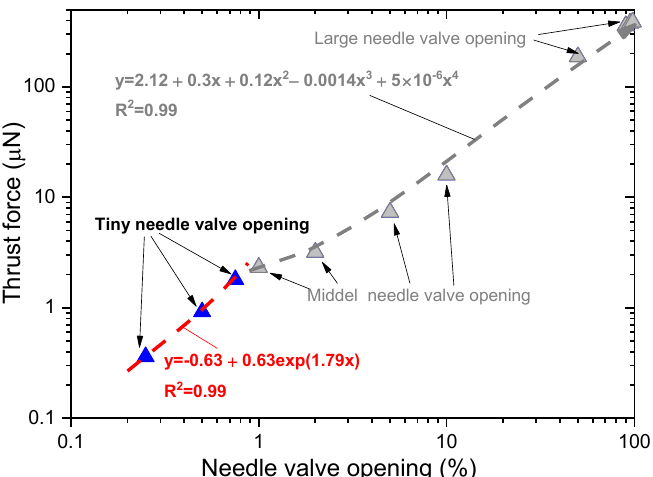
Figure 15. Computational thrust force with different valve opening ratios at t = 0.1 ms. Blue triangle symbols are the computational thrust forces under the needle valve opening ratio less than 1%, the red dashed line is the corresponding fitting function. Grey triangle symbols are the computational thrust forces under the needle valve opening ratio larger than 1%, and the grey dashed line is the corresponding fitting function.